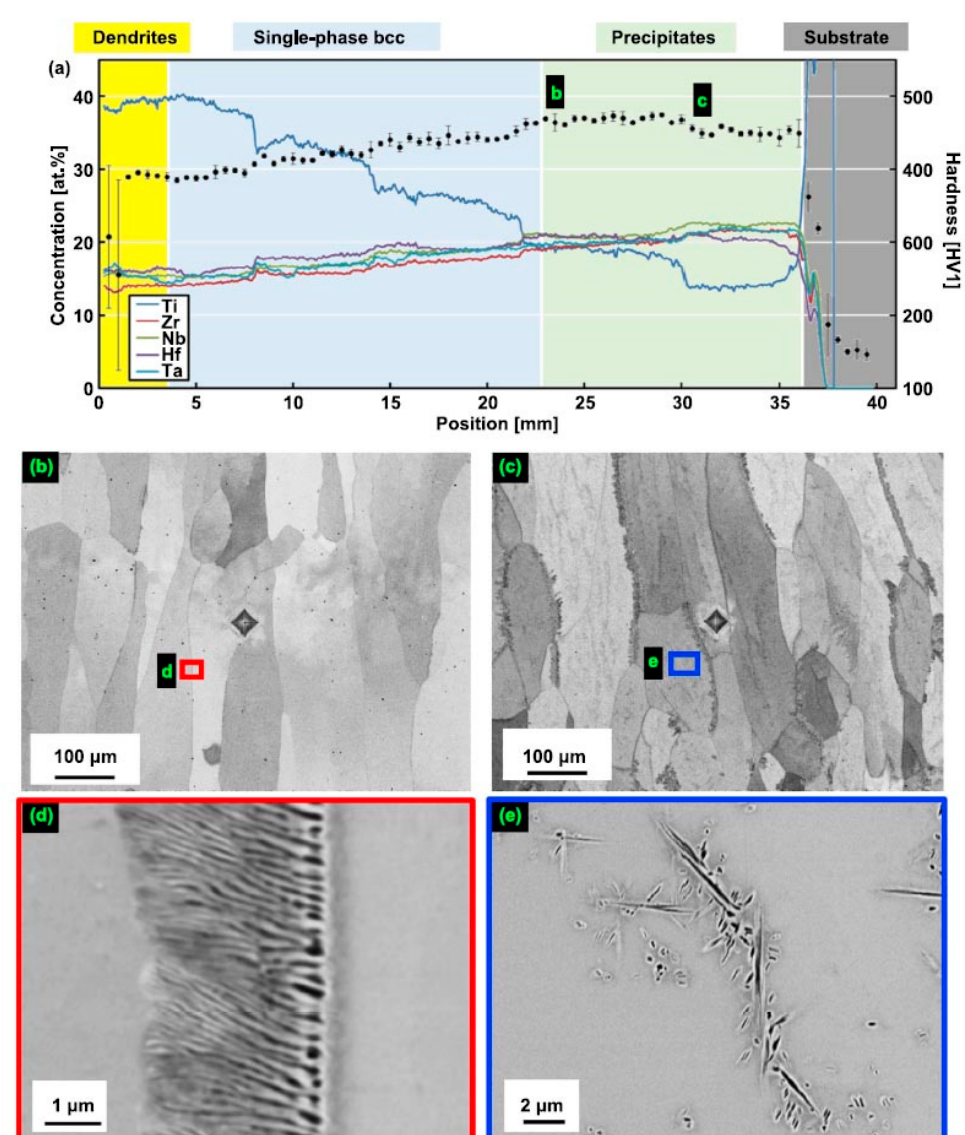
Figure 2. Microstructure of compositionally graded sample built using a blend of five elemental powders [63]. ( a ) The composition was changed from Ti 13.3 Zr 21.7 Nb 21.7 Hf 21.7 Ta 21.7 (right) to Ti 40 Zr 15 Nb 15 Hf 15 Ta 15 (left). The position x = 0 indicates the top of the columnar specimen while positions to the right of x = 36 mm are located within the Ti substrate. The concentrations of the alloying elements (left y -axis) are shown as continuous lines, and hardness values (right y -axis) are given with black dots and error bars. The labels ( b , c ) indicate the positions where the microstructure was investigated by SEM and found to exhibit two phases. In figures ( b , c ), small areas marked with colored frames are magnified in ( d , e ), respectively. Lamellar precipitates were found at grain boundaries ( b – e ). Additionally, plate-shaped precipitates formed within grains at location ( c , e ). Reprinted with permission from Ref. [63]. Copyright 2021 Elsevier.